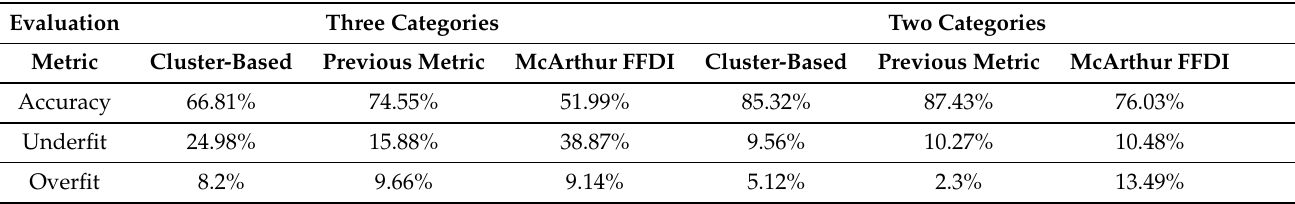
Figure 6. Confusion matrix for the performance analysis of the risk metric. ( a ) Three different fire risk categories. ( b ) Two different fire risk categories. Table 4. Performance comparison against the McArthur